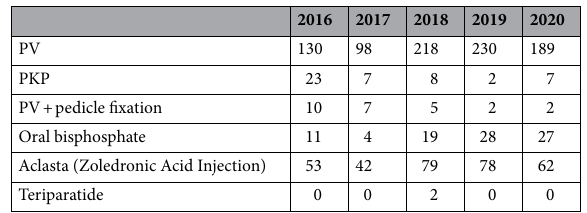
Table 3. Surgical and drug management of OVCF patients over 5